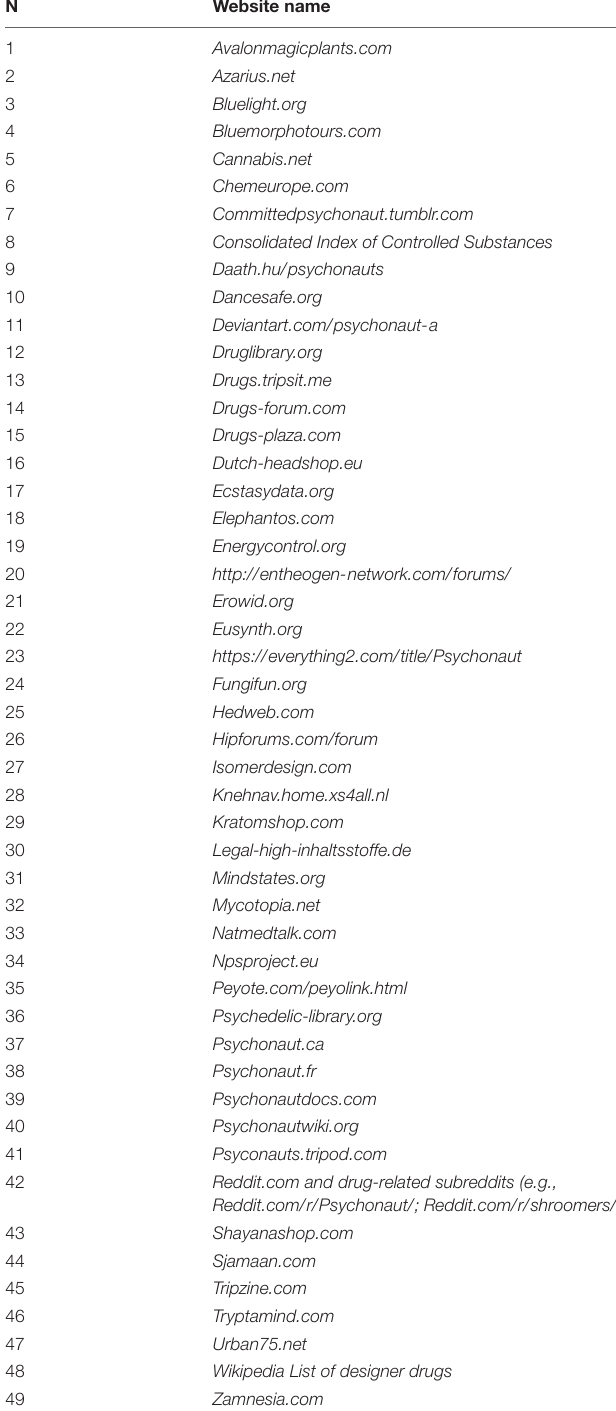
TABLE 1 | NPS.Finder R (cid:13) websites’ list; search activities carried out on the surface web